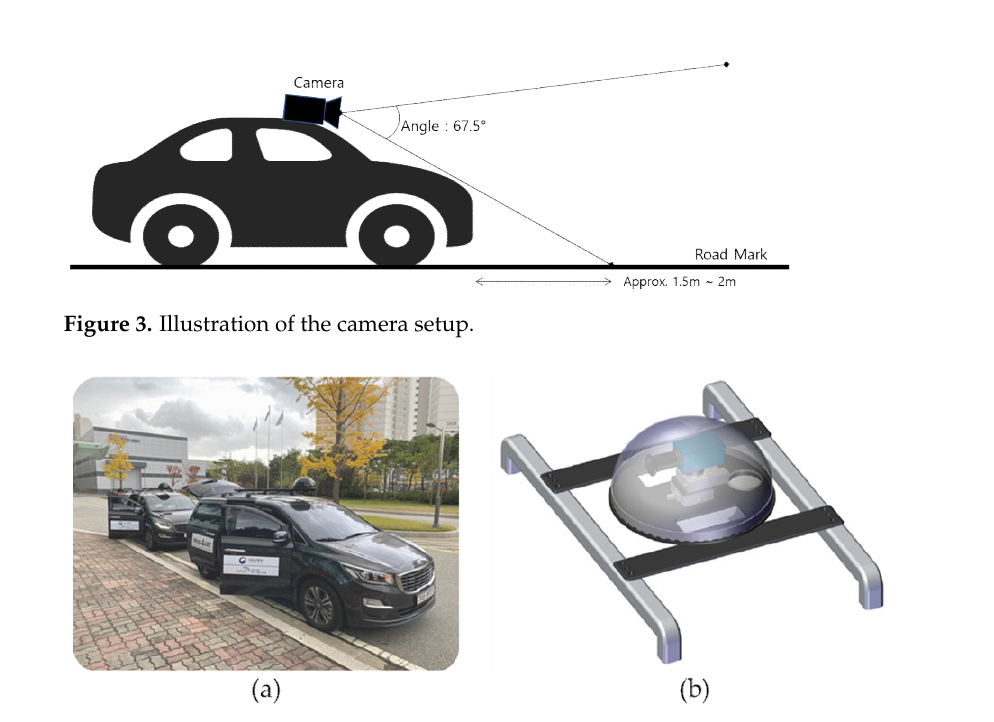
Figure 4. ( a ) DCS vehicle and ( b ) 3D model of the camera lens housing.